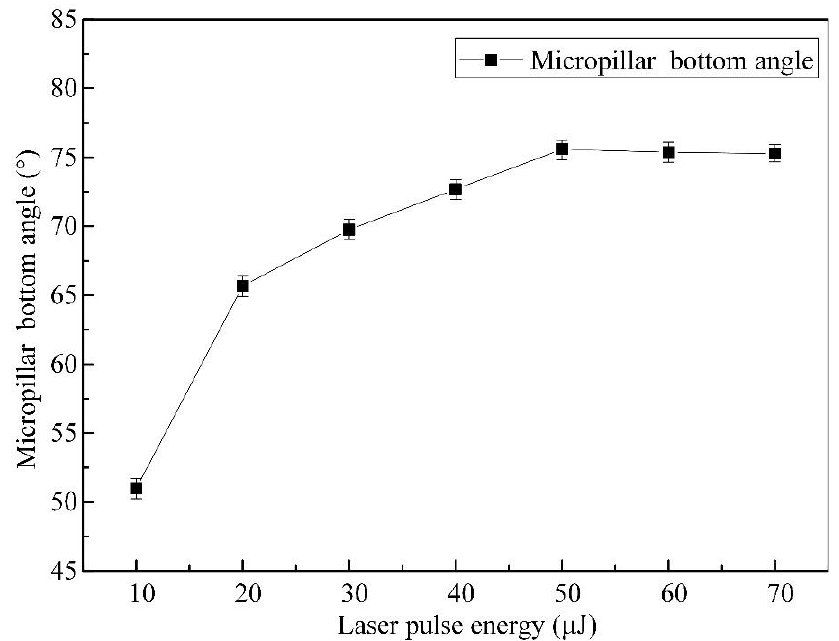
Figure 6. Effect of pulsed beam energies on the bottom angle of the micropillars with a translation velocity of 1.0 m/s and a pulsed repetition rate of 600 kHz. Three-dimensional (3 D) microscope images and geometric profiles for various laser beam energies with a constant laser translation velocity of 1.0 m/s are displayed in Figure